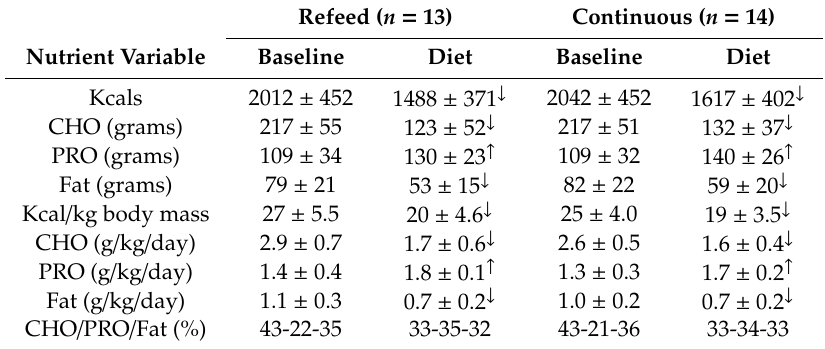
Table 2. Macronutrient intake (mean ±